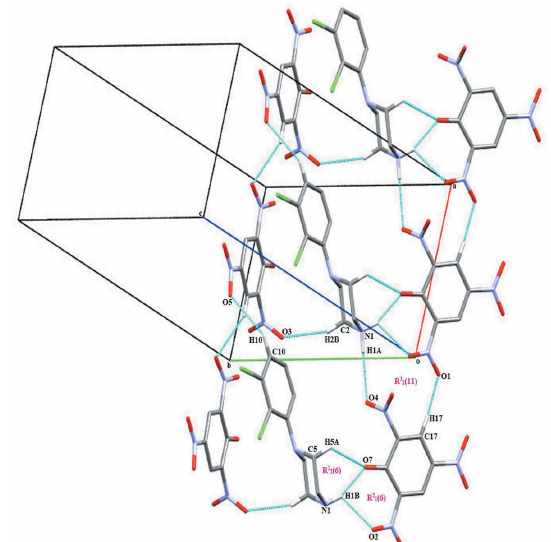
Figure 2 A view of the N—H (cid:3)(cid:3)(cid:3) O and C—H (cid:3)(cid:3)(cid:3) O hydrogen-bonded packing pattern of the title salt.